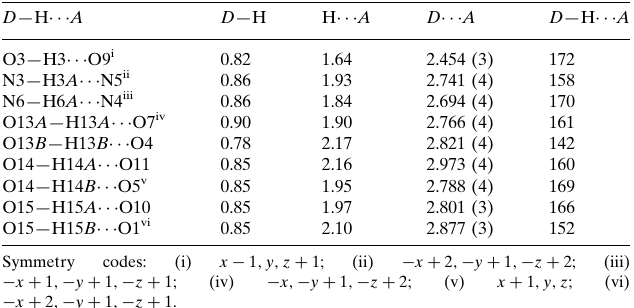
Hydrogen-bond geometry (A˚ , (cid:2) ). D —H (cid:1)(cid:1)(cid:1)